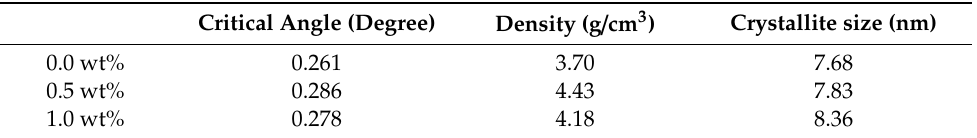
Table 1. Critical angle, Film density, and Crystalline size of solution-processed SnO 2 films doped with 0–1 wt% Mg.